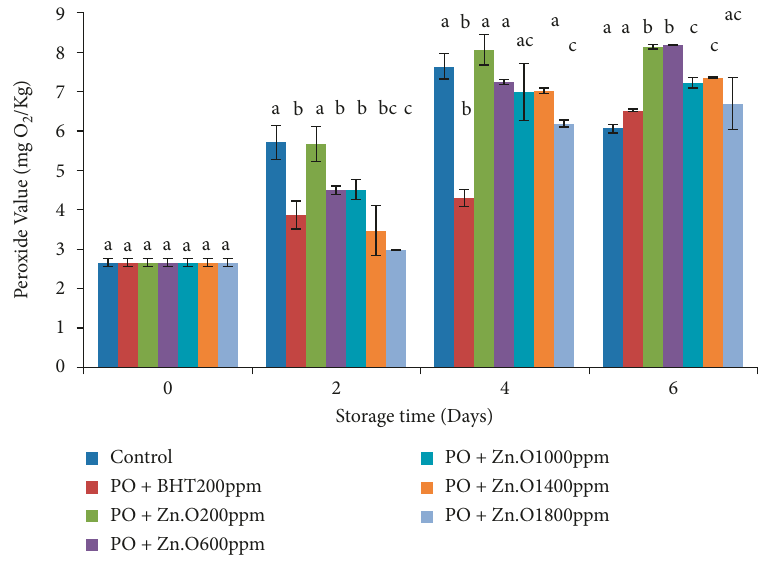
Figure 1: Changes in peroxide value of palm olein enriched with different concentrations of ginger extract throughout a storage at frying temperature. BHT: butylated hydroxytoluene; PO: palm olein; Zn.O: Zingiber officinale (ginger); control: palm olein without antioxidant; PO+BHT 200 ppm : palm olein+ 200ppm BHT; PO +Zn.O 200ppm : palm olein+200ppm ginger root extract; PO +Zn.O 600ppm : palm olein+600ppm ginger root extract; PO+Zn.O 1000ppm : palm olein+1000ppm ginger root extract; PO+Zn.O 1400ppm : palm olein+1400ppm ginger root extract; PO +Zn.O 1800ppm : palm olein+1800ppm ginger root extract. Data are presented as mean ± standard deviation ( n � 3). a–d values of the same storage day with different superscripts are significantly different at p < 0 . 05. Data are presented as mean ± standard deviation ( n � 3). a–c values of the same storage day with different superscripts differ considerably at p < 0 .